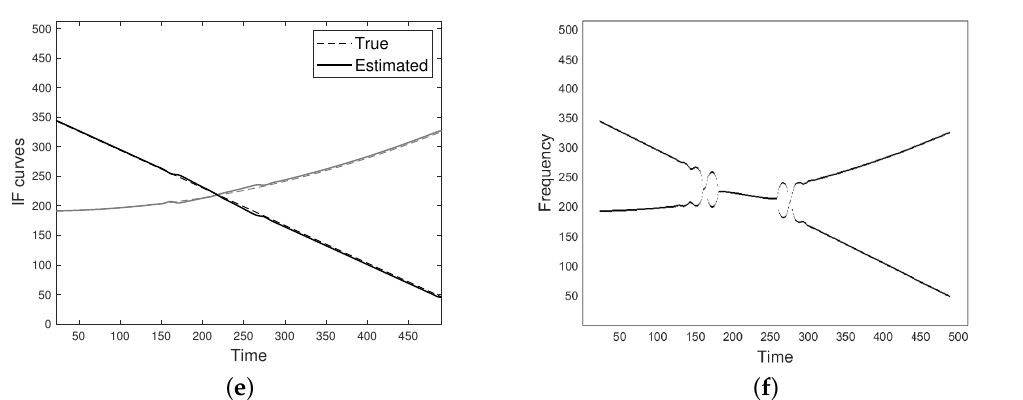
Figure 7. ( a ) Spectrogram of a two-component signal with crossing modes (destructive interference). ( b ) Distance function as defined in Equation (26) and detected crossing point (star). ( c ) Spectrogram section. The star markers indicate spectrogram values at the frequency points ξ 1 , ξ 2 for defining the linear system, as in Equation (11). ( d ) Estimated chirp rates compared to the true ones. ( e ) Estimated IFs. ( f ) IF curves estimated from spectrogram